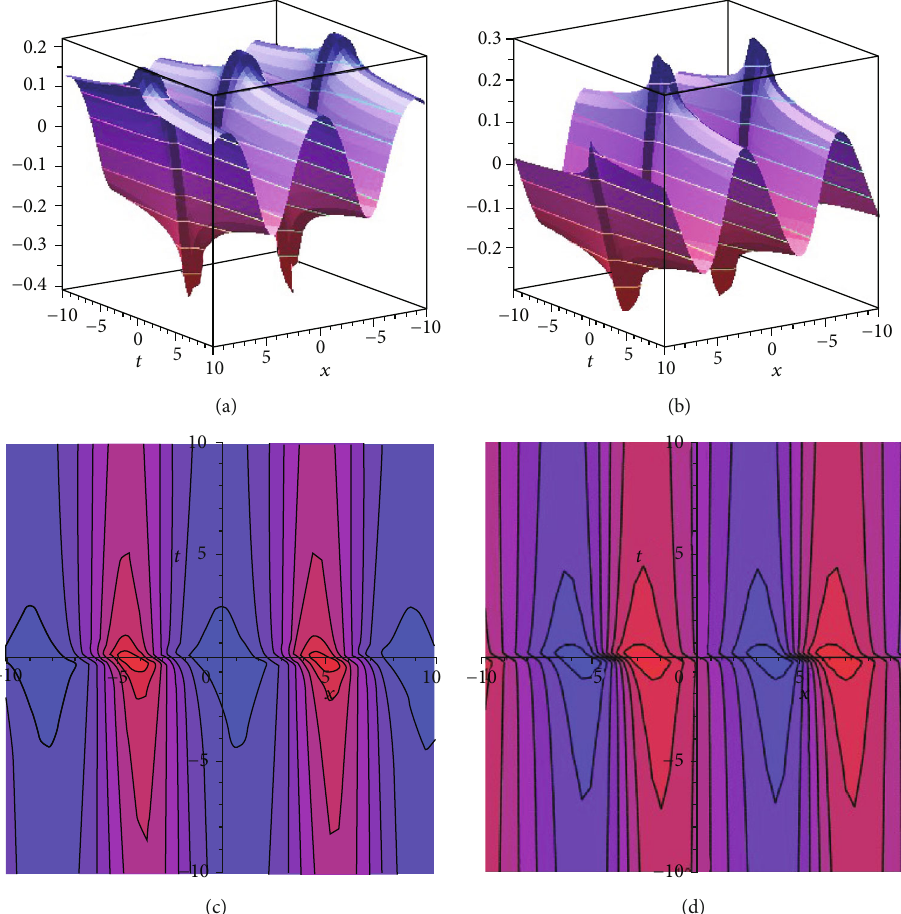
ð x , t Þ : (a) real three-dimensional shape, (b) complex three-dimensional shape, (c) 3